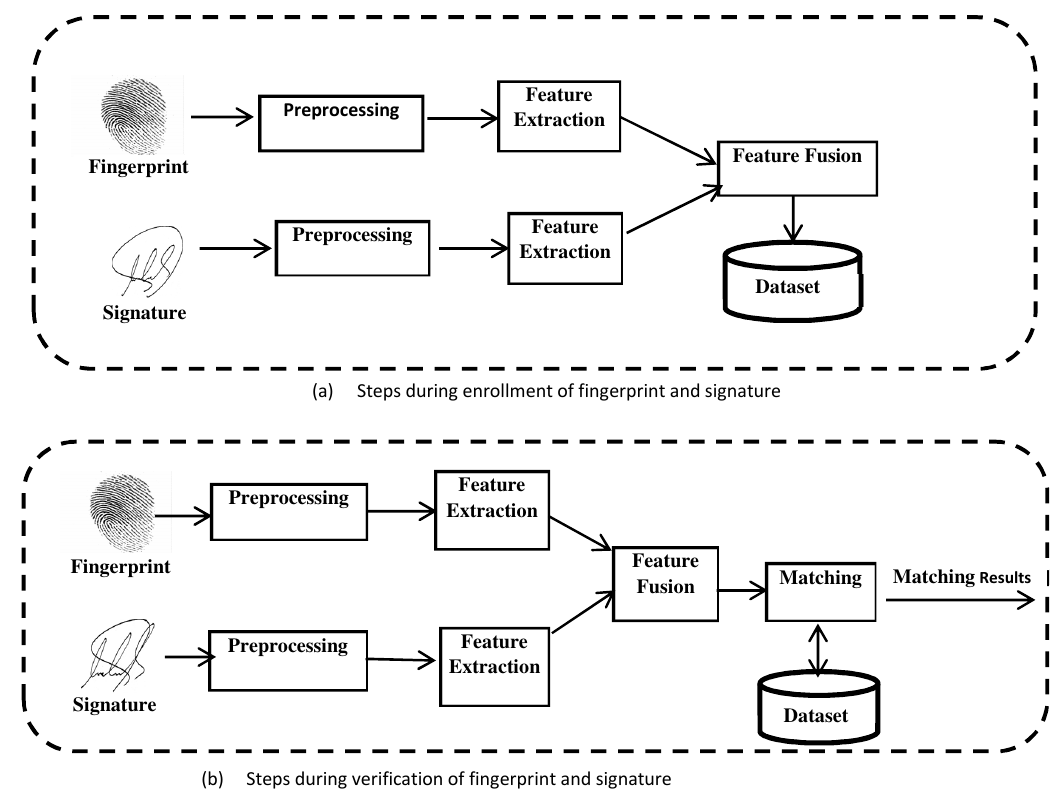
FIG. 3: DIFFERENT STEPS AND SUB STEPS DURING (a) ENROLLMENT PHASE AND (B) VERIFICATION OF PROPOSED